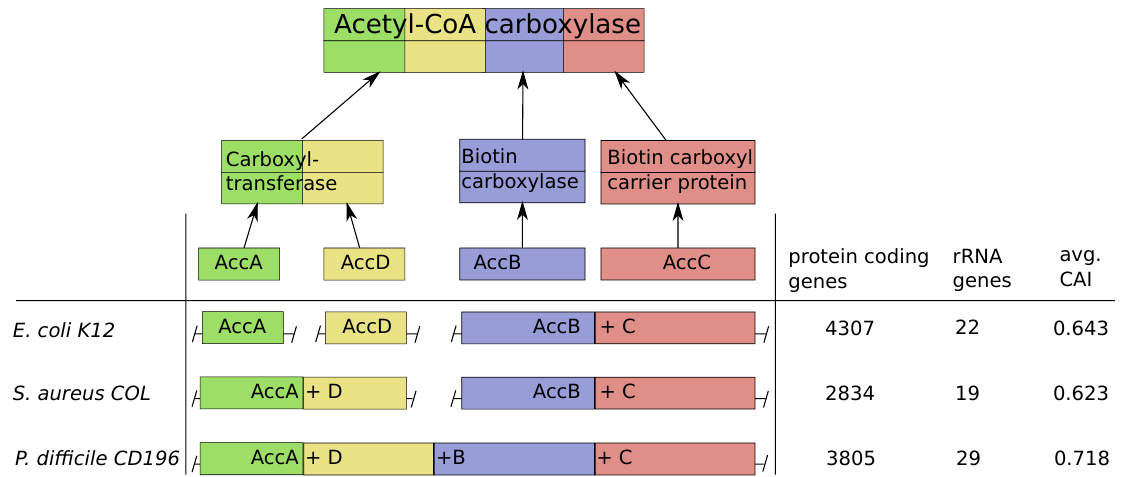
Figure 6. Acetyl-CoA carboxylase composition and operonic structure in three prokaryotic genomes. The colors and number of blocks represent schematically the subunit structure: [( AccA ) ( AccD ) ][( AccC ) ][( AccB ) ] . Next to the operon structure in each organism, 2 2 2 2